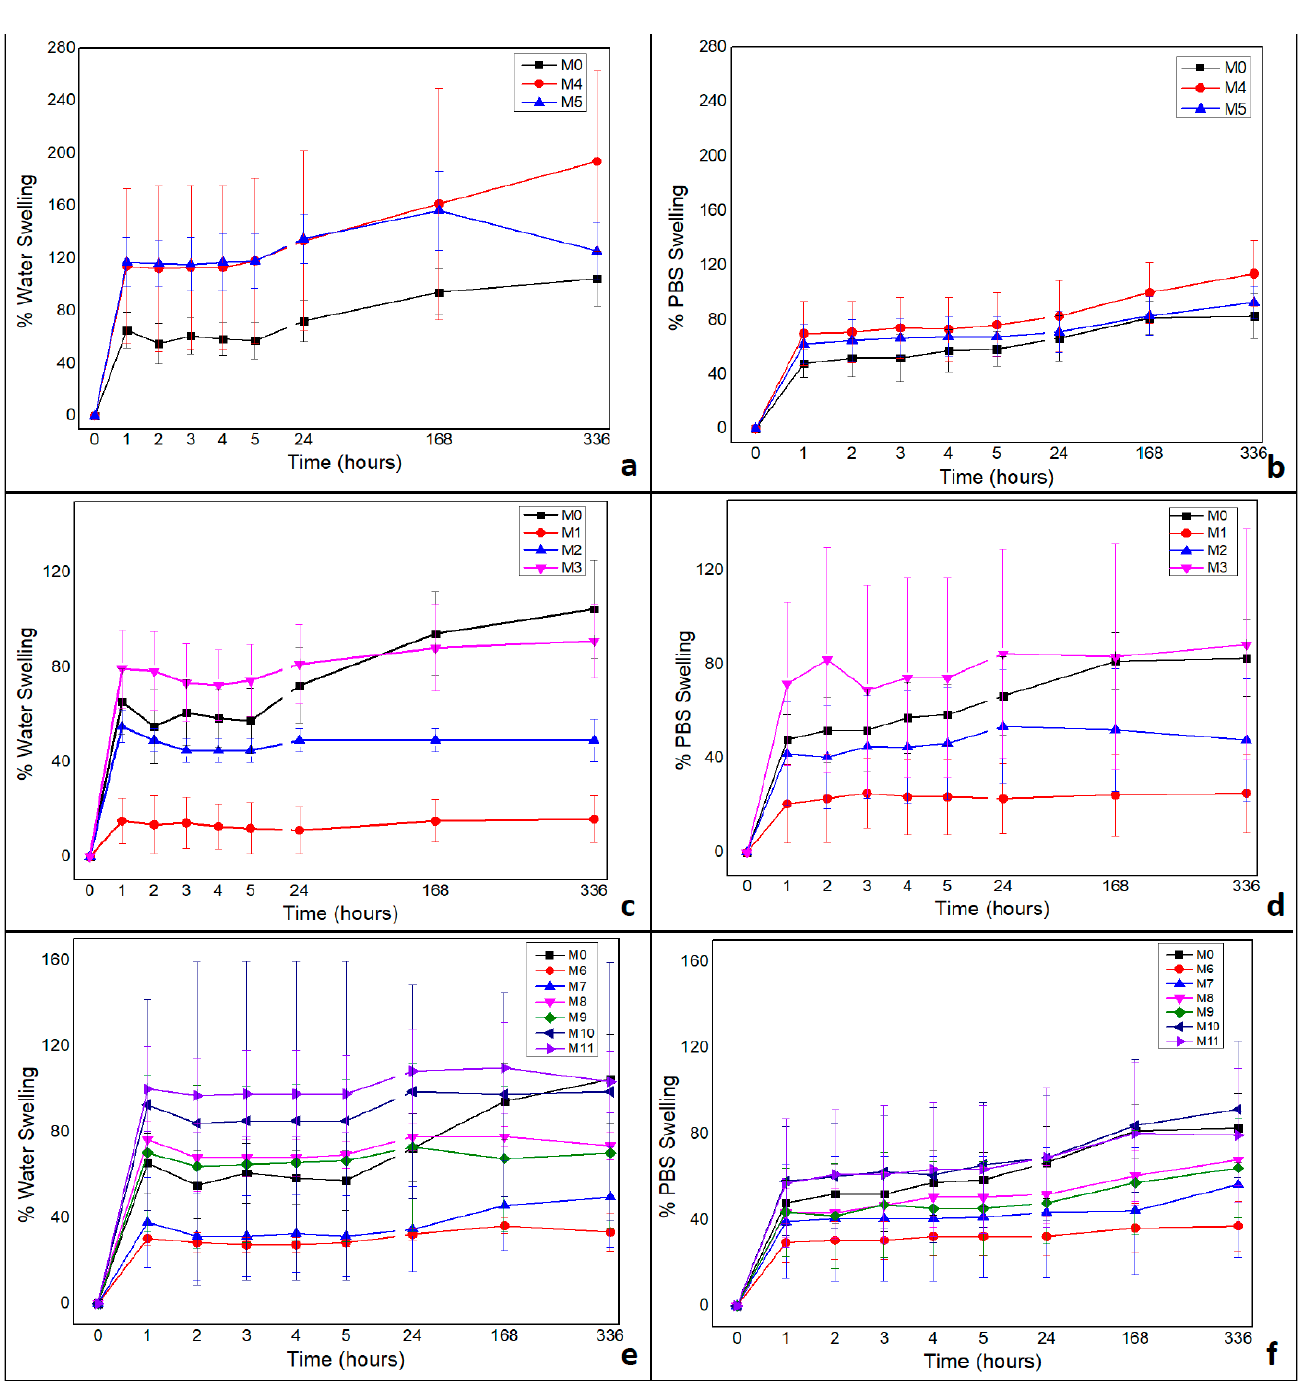
Figure 4. Comparison of the percentage of membrane swelling in water and in PBS. The membranes composed of chitosan and andiroba oil swelling in water ( a ) in PBS ( b ); the percentage of swelling of the membranes containing green banana peel extract from the first and second decoction days (M1 and M2) respectively in water ( c ) and in PBS ( d ); the percentage of swelling of the membranes containing green banana peel extract from the third day of decoction (M10 and M11) in water ( e ) and in PBS ( f